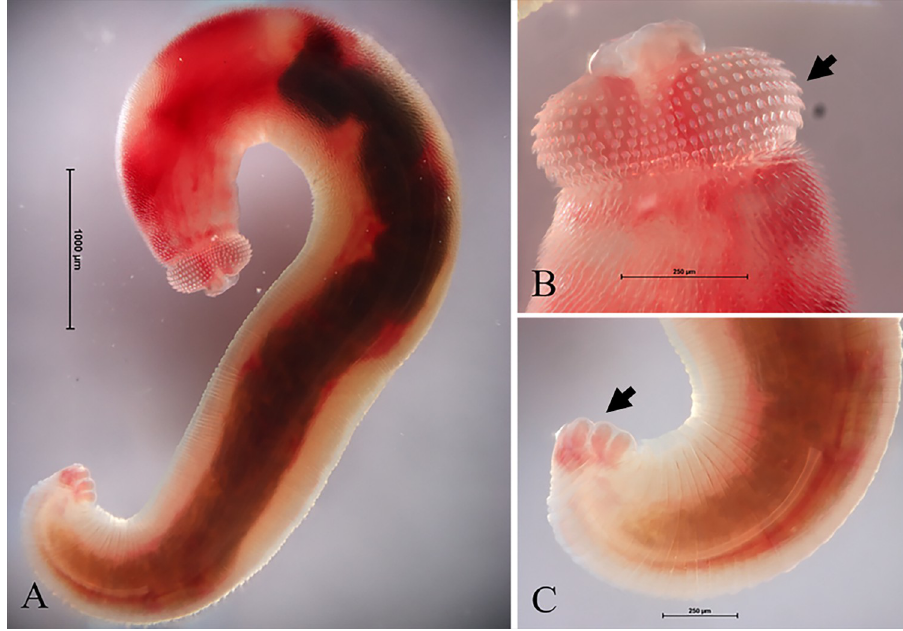
Fig 1. Light micrograph of permanent stain of STIM. (A); Head bulb with eight rows of cephalic hooklets (B); Caudal area (C).